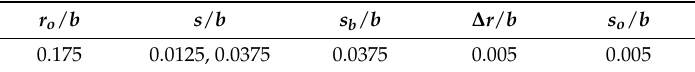
Figure 3. A sketch of the main region of the test rig (not to scale). r o : radius of the outlet pipe; s b : axial gap width of the back chamber (BC), ∆ r : radial gap; s o : axial width of the inlet. Table 1. Main parameters of the test zone in this study.